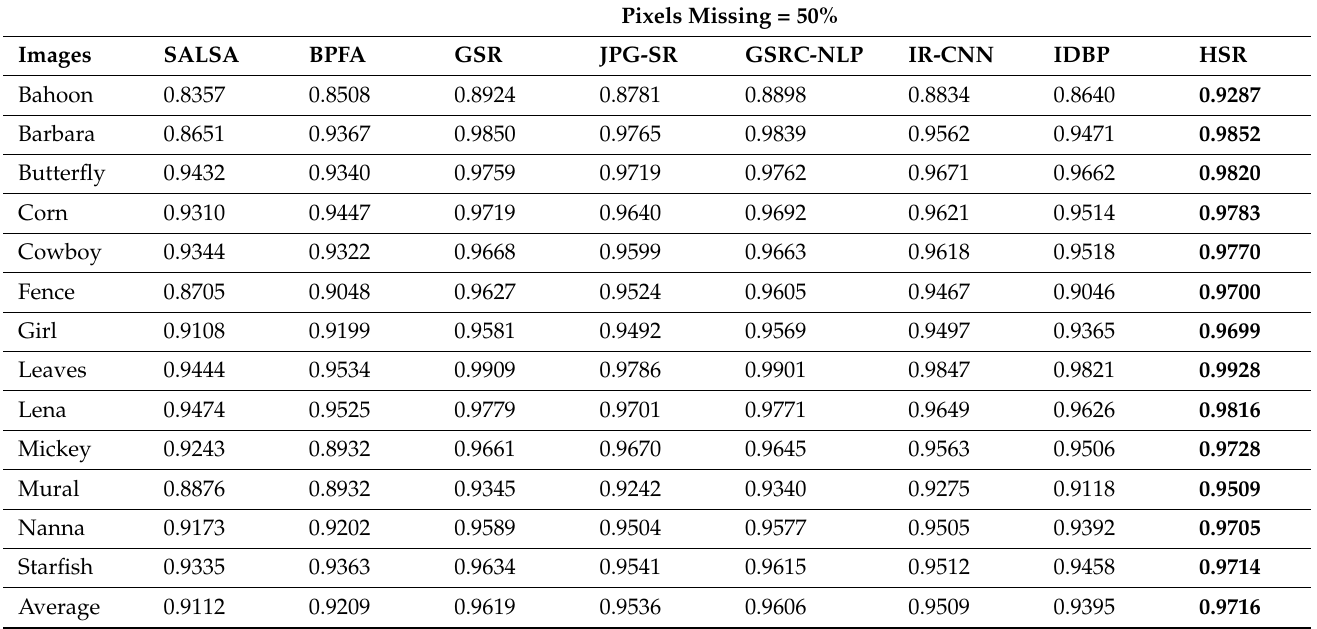
Table 8. SSIM values of our proposedSR model and other comparison models after image restoration with pixels rate